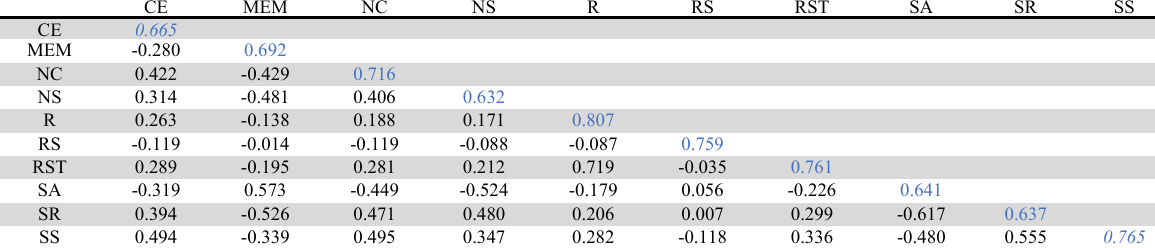
Discriminant validity: Latent construct correlation (Fornell-Larker criterion)